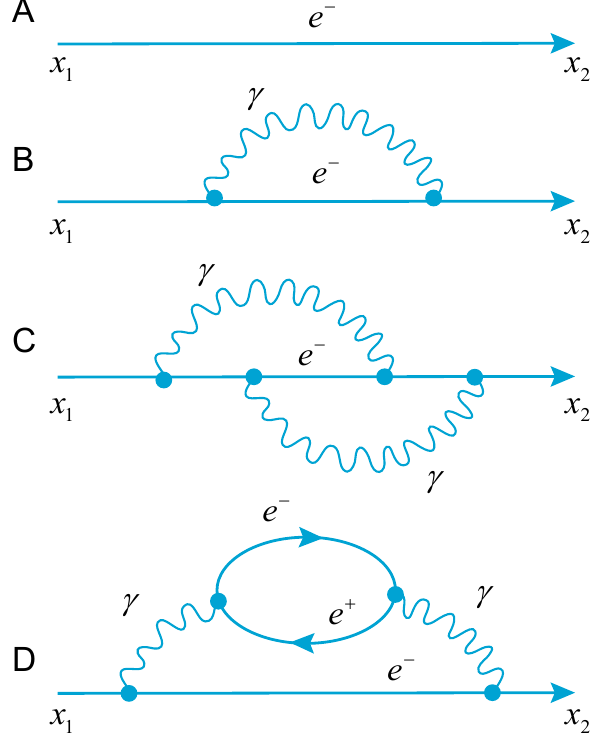
Figure 1: Feynman diagrams showing some of the various in- teractions between quantum fields during transit of a quantum particle like an electron e − from x 1 to x 2 (A). (B) Interaction of an electron with the photon field, which is commonly described as the emission of a virtual photon γ by the electron and then reabsorbing it. (C) Emission of two photons and re-absorption by the electron. The photon in turn can create disturbances in the various quantum fields involving a charge. The virtual photon can emit an electron-positron pair e − + e + as shown in (D), a muon-anti muon pair, a quark-antiquark pair, etc.